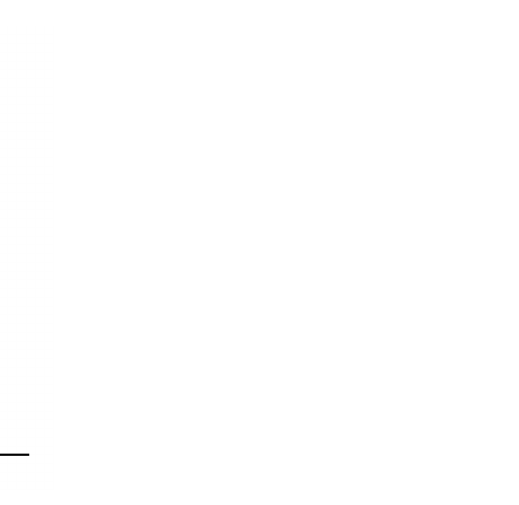
Figure 5. Basic geometry for across-track SAR interferometry. The two sensing platforms (positioned at X and Y) are travelling along parallel trajectories normal to the page. All illustrated sensors, lines and arcs lie on a single plane sharing that normal. (based on [36], Figure